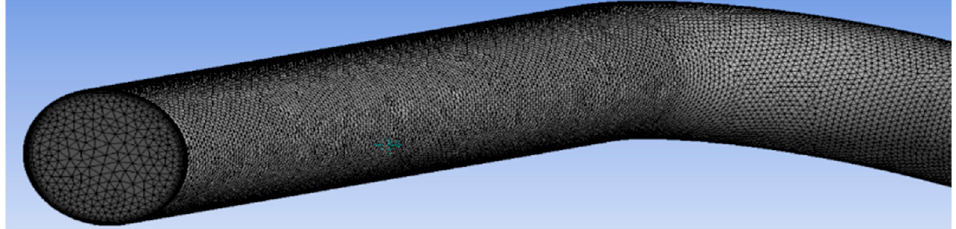
Figure 4. 3D model of the elbow.